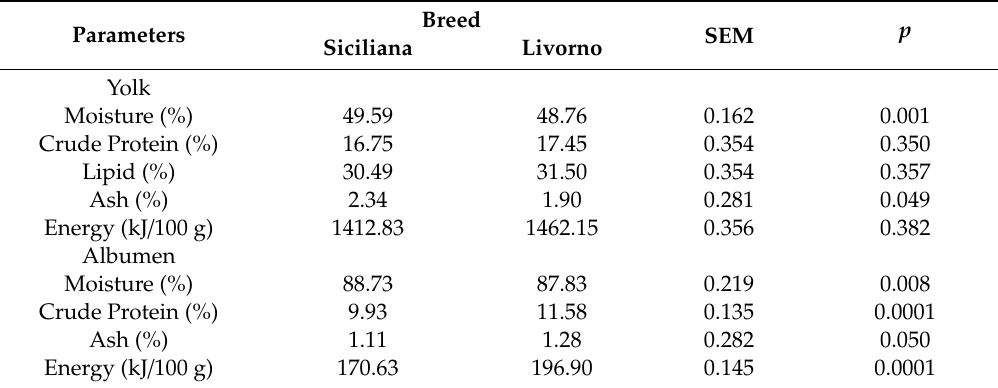
Table 3. Chemical composition of yolk and albumen.